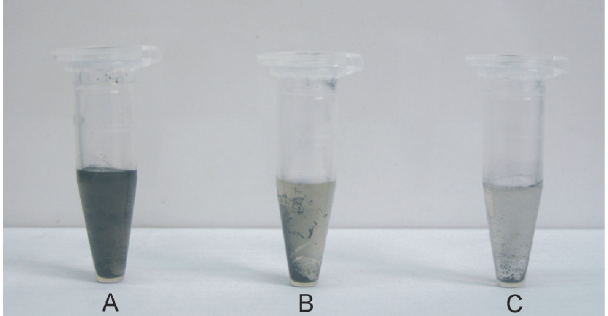
Figure 2. Photograph of SWCNT–water mixture in the absence (C), presence of the symmetric PCR product (B) and asymmetric PCR product (A) after centrifugation at 3000 rpm for 30